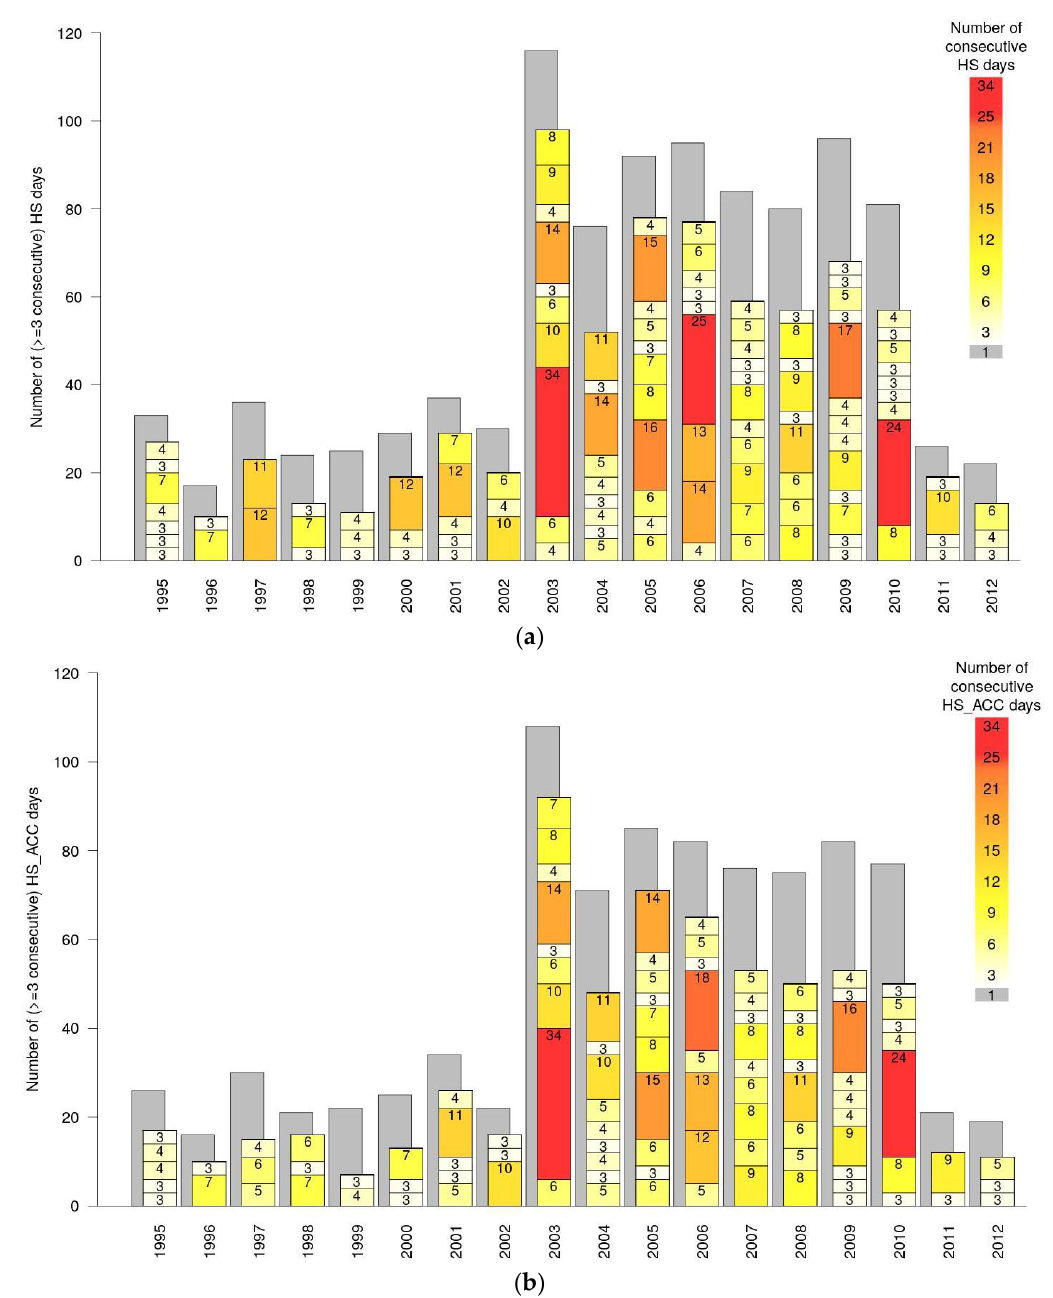
Figure 8. Consecutive number of days with heat stress for Freiburg during the time period 1995–2012: ( a ) without acclimatisation effects and ( b ) with acclimatisation effects. Grey bars depict the total number of HS respectively HS ACC days of the year.